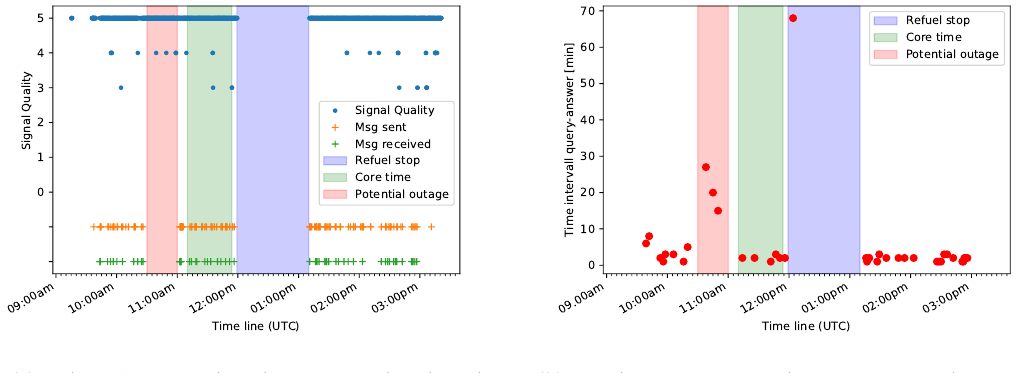
Figure 8. Iridium Short Burst Data (SBD) signal and response